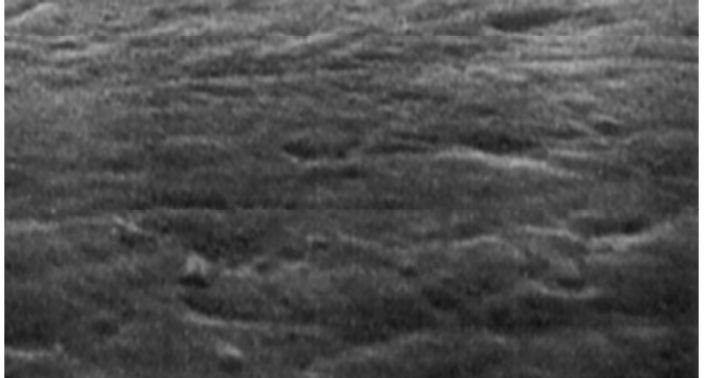
Figure 12. Scanning electron microscopy images of PoAP film (thicknes 60 nm) deposited on the rotating disc gold electrode. Reprinted from [14] with permission from